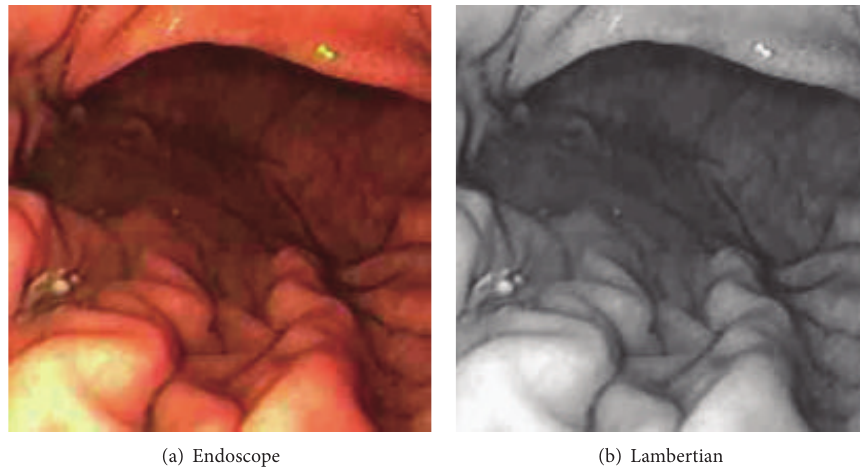
Figure 14: Endoscope image and generating Lambertian image.